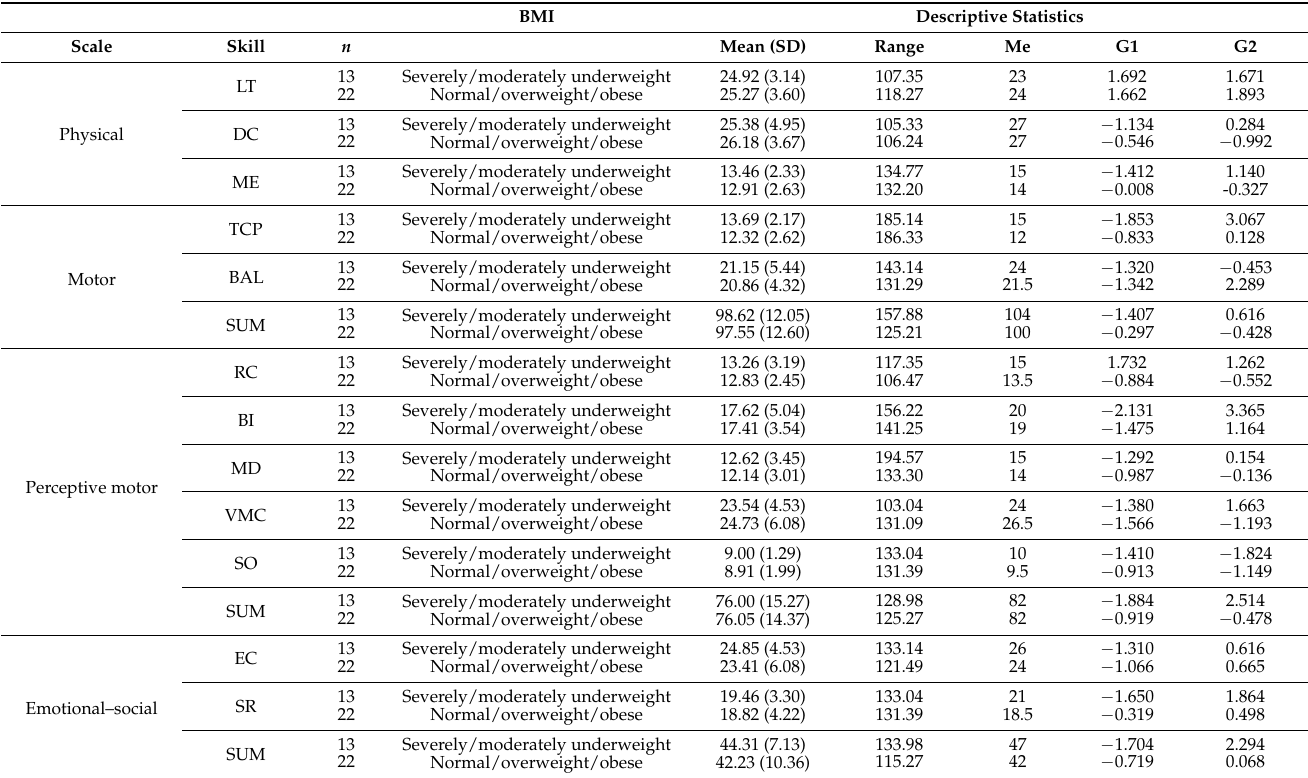
Table 1. Description of variable in premature children (Checklist of Psychomotor Activities (CPA)).